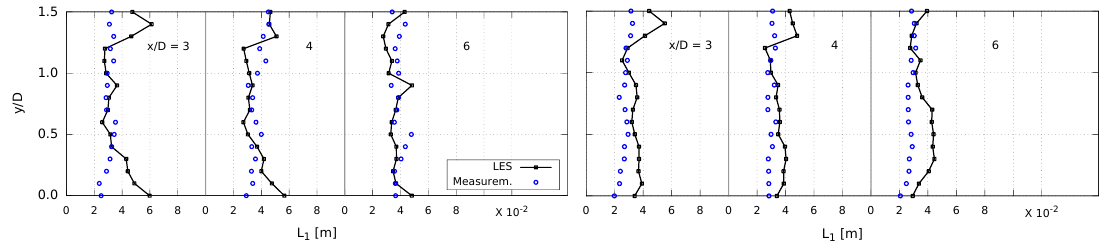
Figure 14. Vertical profiles of L 1 behind the AD with inflow Ti12, disk C T = 0.45 ( left ) and C T = 0.71 ( right